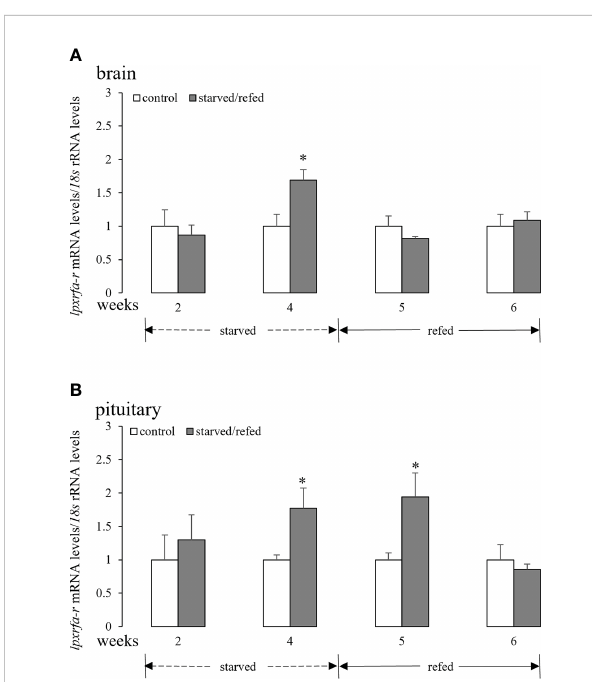
FIGURE 3 Effects of nutritional status on the brain (A) and pituitary (B) kiss2 mRNA levels in half-smooth tongue sole. Data were normalized against 18s transcripts and are presented as mean ± SEM (n = 4). A star indicates signi fi cant difference between fed and starved/refed groups ( p < 0.05).